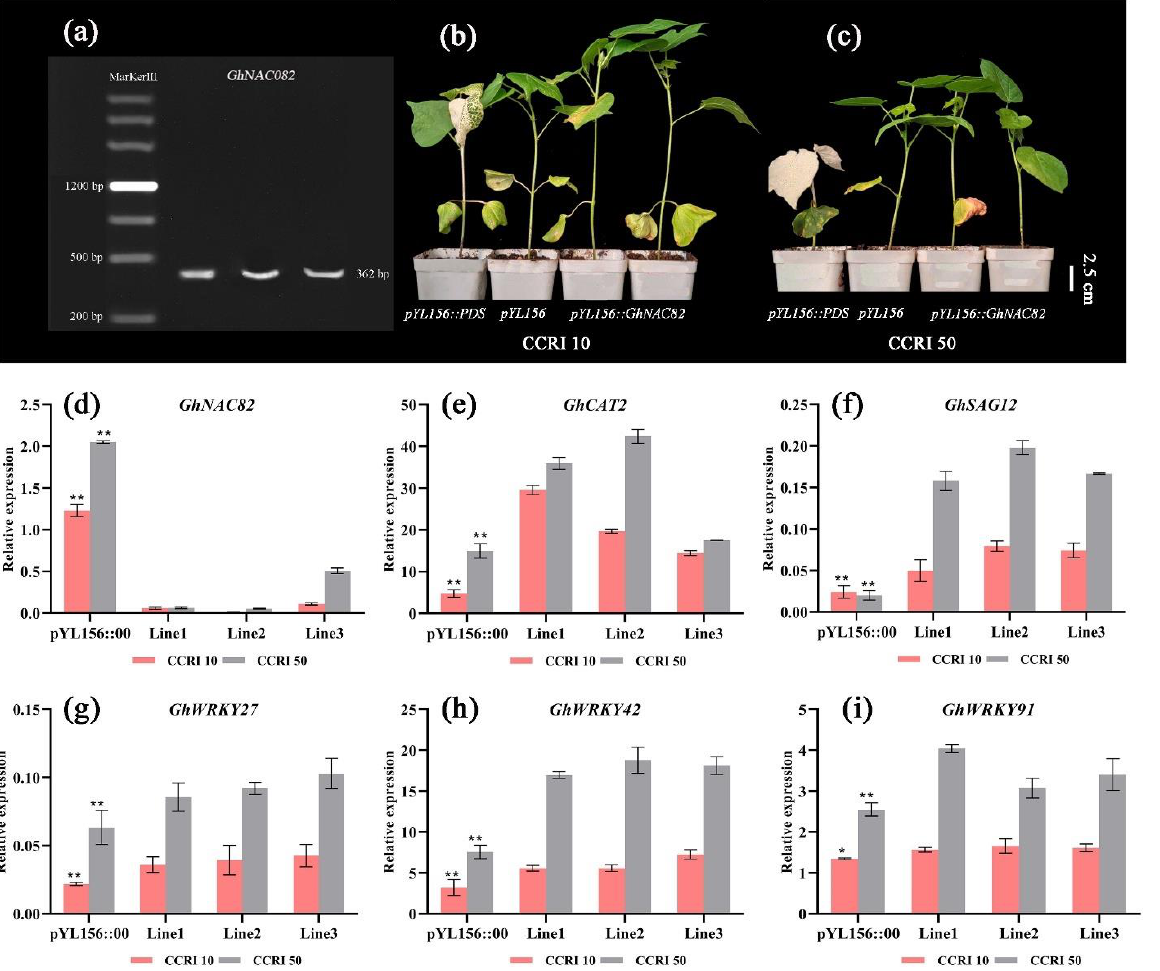
Figure 8. Phenotype and related gene expression of GhNAC82 -silenced. ( a ) Agarose gel electrophoresis detection; ( b , c ). Comparison of plant height among positive control, negative control and silenced plants in CCRI 10 and CCRI 50; ( d – i ) Expression of GhNAC82 , GhCAT2 , GhSAG12 , GhWRKY27 , GhWRKY42 and GhWRKY91 in negative control and silent plants. *: Significance at p < 0.05; **: Significance at p < 0.01.